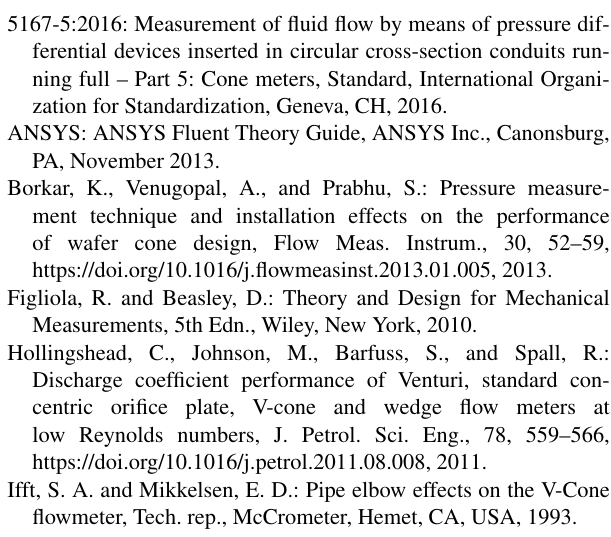
Figliola, R. and Beasley, D.: Theory and Design for